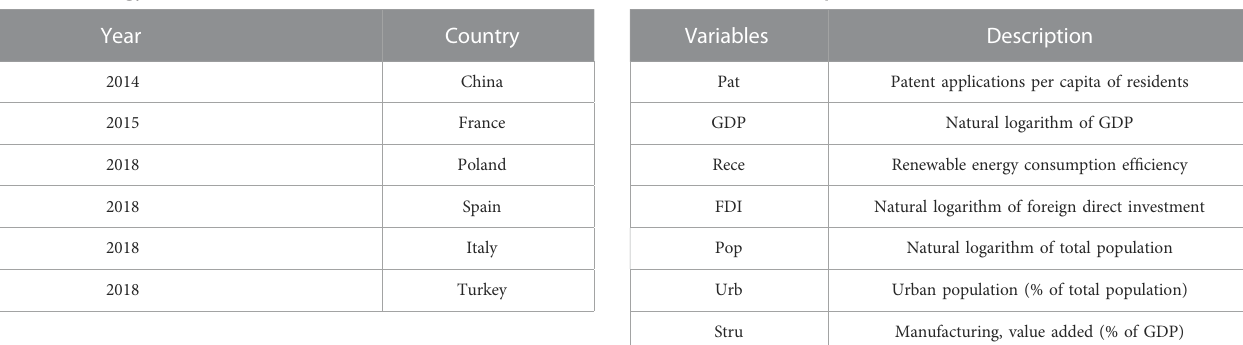
TABLE 1 Solar energy investment in